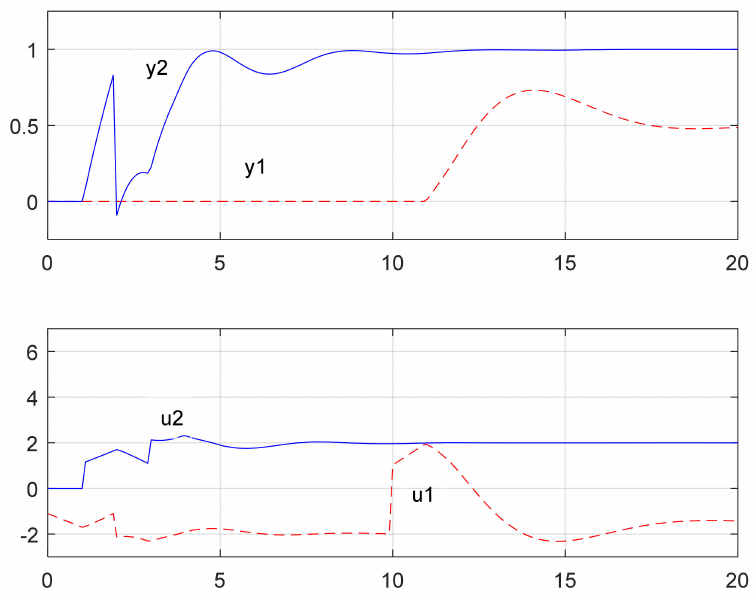
Figure 6. Reference tracking and disturbance regulation with considerate pre–compensation. Upper plot shows the system outputs y 1 and y 2 as functions of time. Lower plot shows the system inputs u 1 and u 2 as functions of time. The references in Figure 1 are r 1 = 0.5 σ ( t − 10 ) and r 2 = 1. The output disturbances in Figure 1 are d 1 = 0 and d 2 = − σ ( t − 2 ) , where σ ( t ) is the unit step function (or rather distribution) at time t =